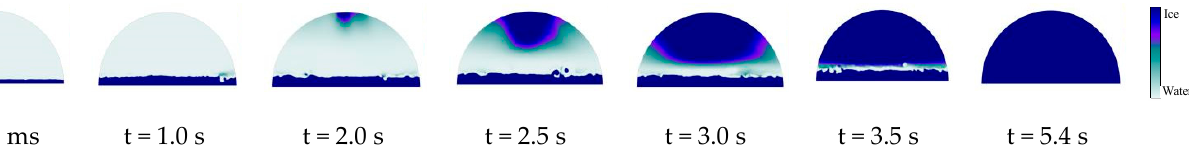
Figure 20. Freezing of the water droplet at 243.15 K.